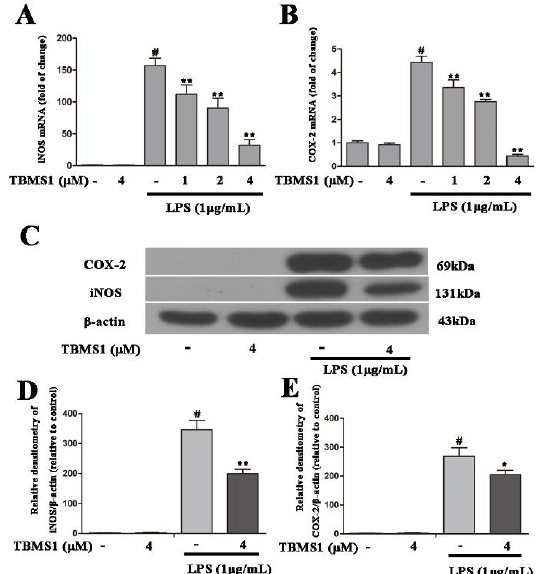
Figure 6. Effects of TBMS1 on the production of pro-inflammatory enzymes in LPS-exposed BV-2 cells. The mRNA levels of inducible nitric oxide synthase (iNOS) ( A ) and cyclooxygenase-2 (COX-2) (B) in BV-2 cells were examined by quantitative real-time PCR. The relative mRNA levels of iNOS and COX-2 were calculated relative to β